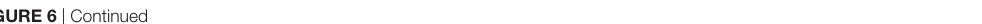
FigUre 6 | Continued Chondrogenic properties of A f , AG f , and AUBM f embedded cells: analysis of cartilage-specific markers. A f , AG f , and AUBM f embedded redifferentiated chondrocytes or chondrocyte micromasses (MM) cultured for 7 or 14 days were compared for chondrogenic capacity by analyzing the expression of cartilage markers. (a) The expression of Col2A1, Col1A1, and aggrecan was evaluated by RT-qPCR. Values obtained from freshly isolated (P0) and dedifferentiated chondrocytes (P6) are also included. Results were calculated using 2 −ΔΔ Ct method, and data are presented as fold change means respect to MM day 7. (B) Quantification of Col2a1/Col1a1 ratio, Col10A1 expression, and GAG content for each experimental condition are reported. Col10a1 expression was assessed by RT-qPCR and resulted not detectable (ND) in all tested conditions. GAG content was quantified by DMMB staining on cellular lysates, and values are reported as µg GAG/ng DNA. All data are presented as means ± SEM of three independent experiments performed on chondrocytes from four different donors ( n = 4).